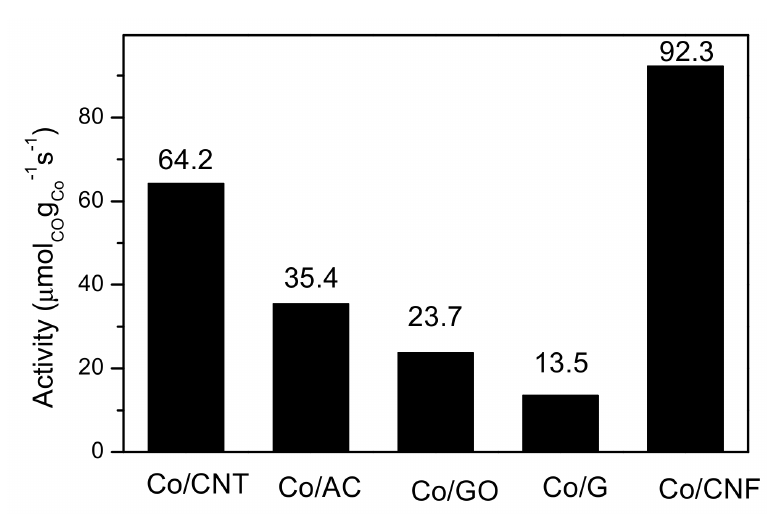
Figure 12. Catalytic activities of different